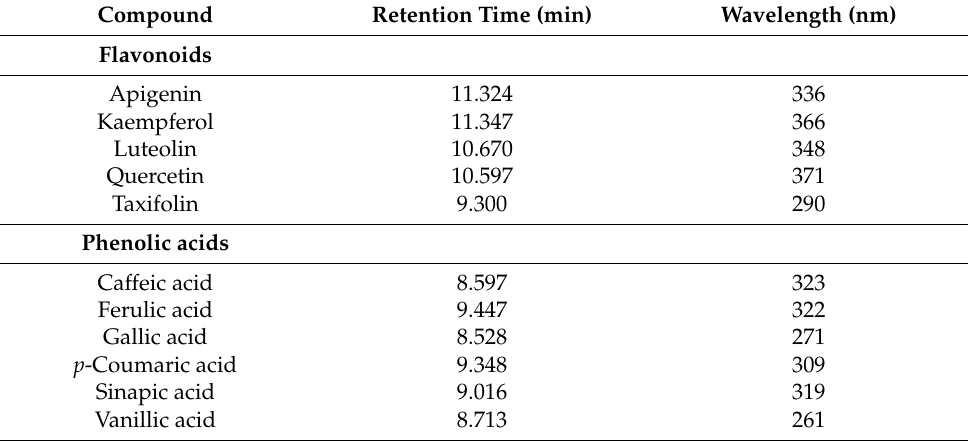
Table 3. Retention times and wavelengths of the quantified phenolic